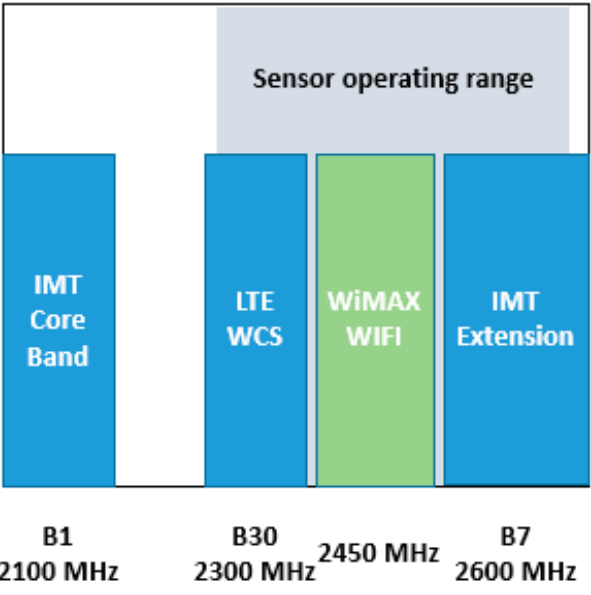
Figure 6. Simulated results of the proposed planar circuit without and with the CSRR element.